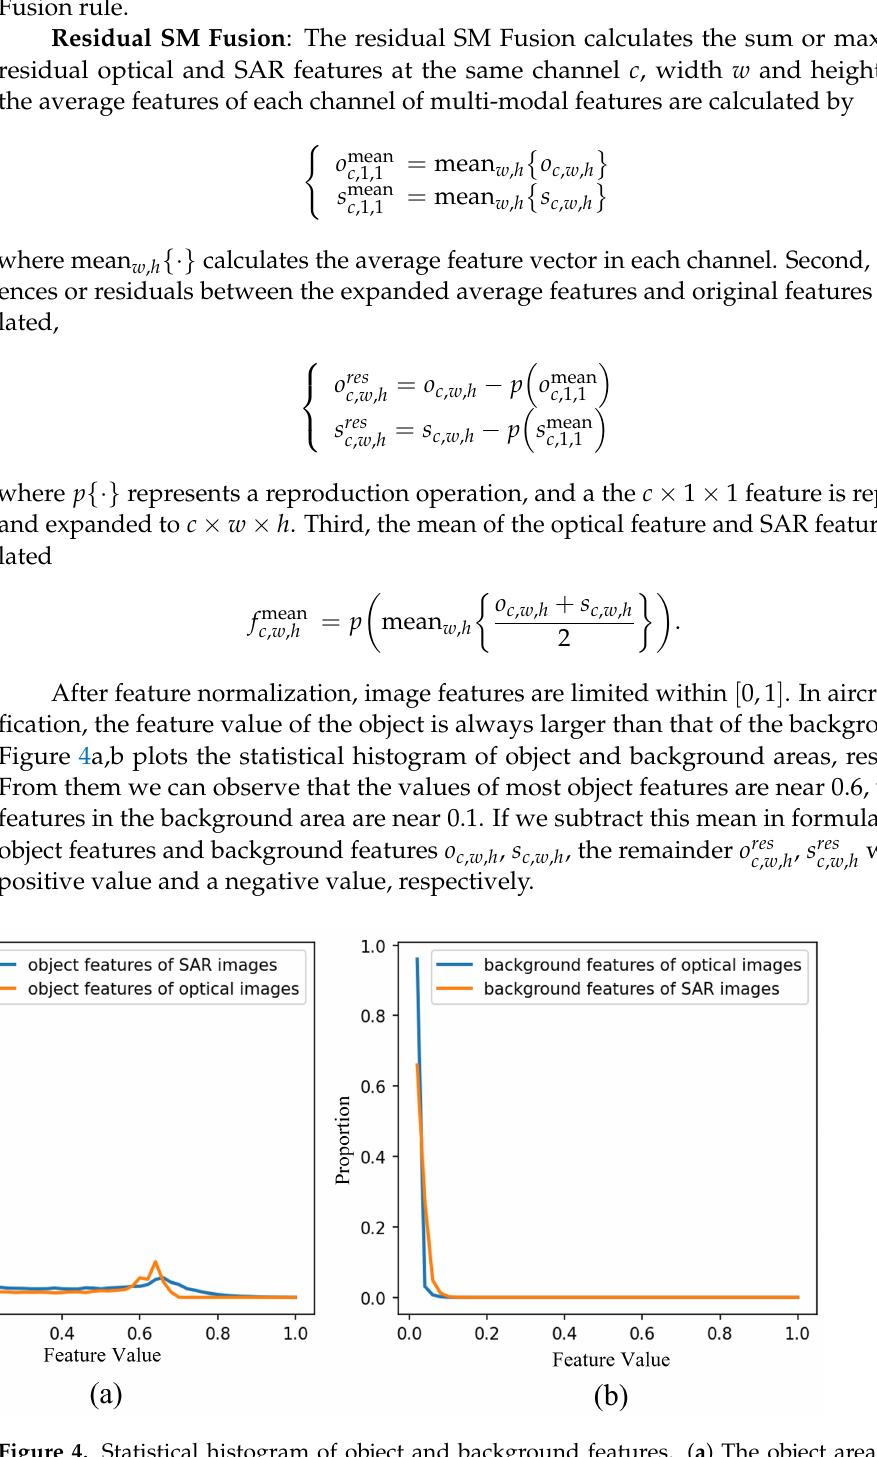
Figure 4. Statistical histogram of object and background features. ( a ) The object areas. ( b ) The background